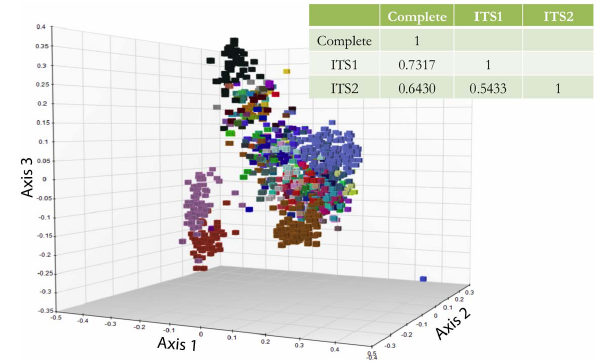
Figure 4. Classification potential of ITS mini-barcodes. NMDS ordination of genetic distances based on ITS1 sequences, with symbols colored by genus. Table inset shows Pearson correlation coefficients between pairwise genetic distance matrices generated for the two spacer regions (ITS1 and ITS2) separately and the full-length sequences from the 1107-sequence dataset.